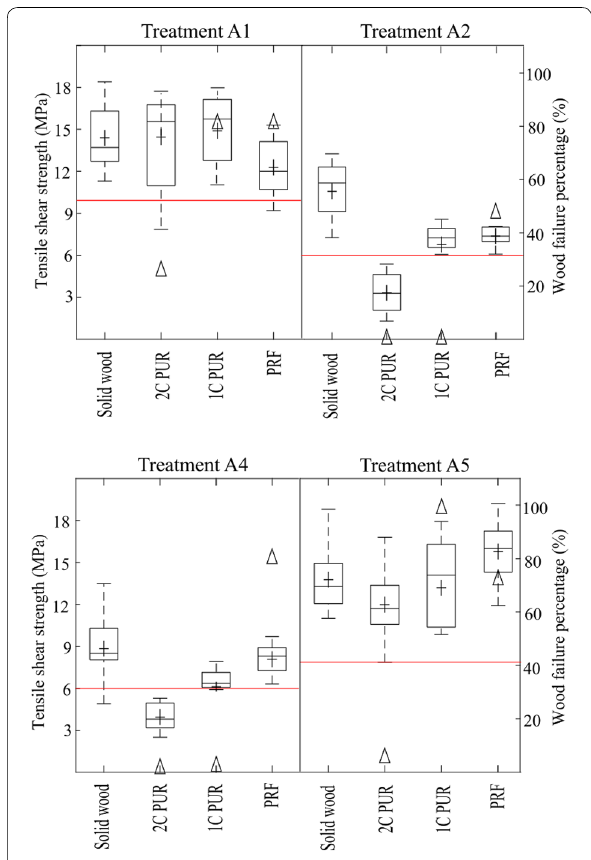
Fig. 5 Boxplots of tensile shear strength (mean value marked as cross) and wood failure (triangle) after treatment A1, A2, A4 and A5 for the adhesives 2C PUR modified with 60% filler, 1C PUR, PRF and the solid wood reference ( n 15). Boxplots indicate median, = interquartile range and minimum and maximum are shown as whiskers. Red line marks standards requirement for each treatment according to EN